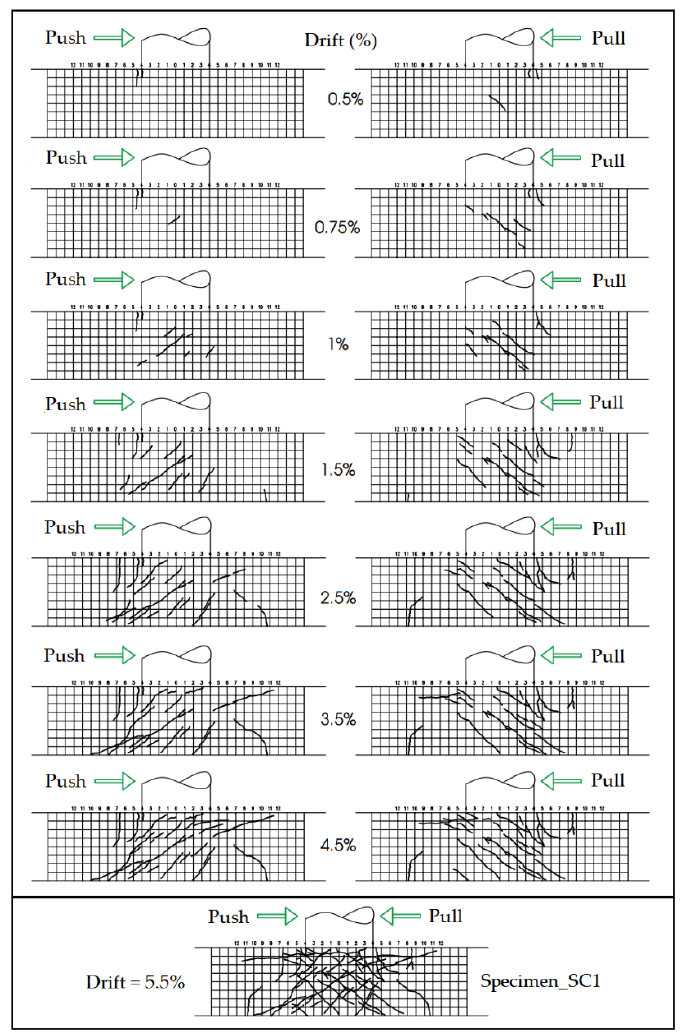
Figure 7. Crack pattern of specimen SC1.